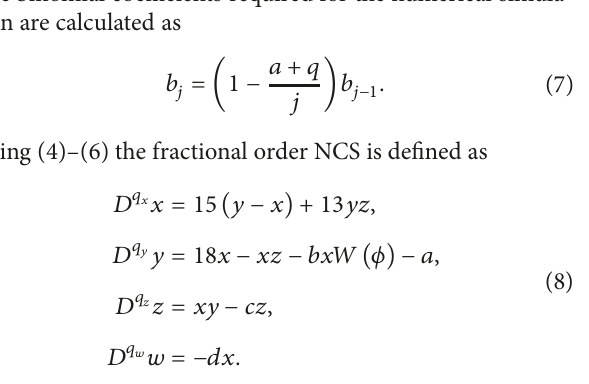
Figure 10: Bicoherence plot of NCS ( 𝑎 = 0, 𝑏 = 0